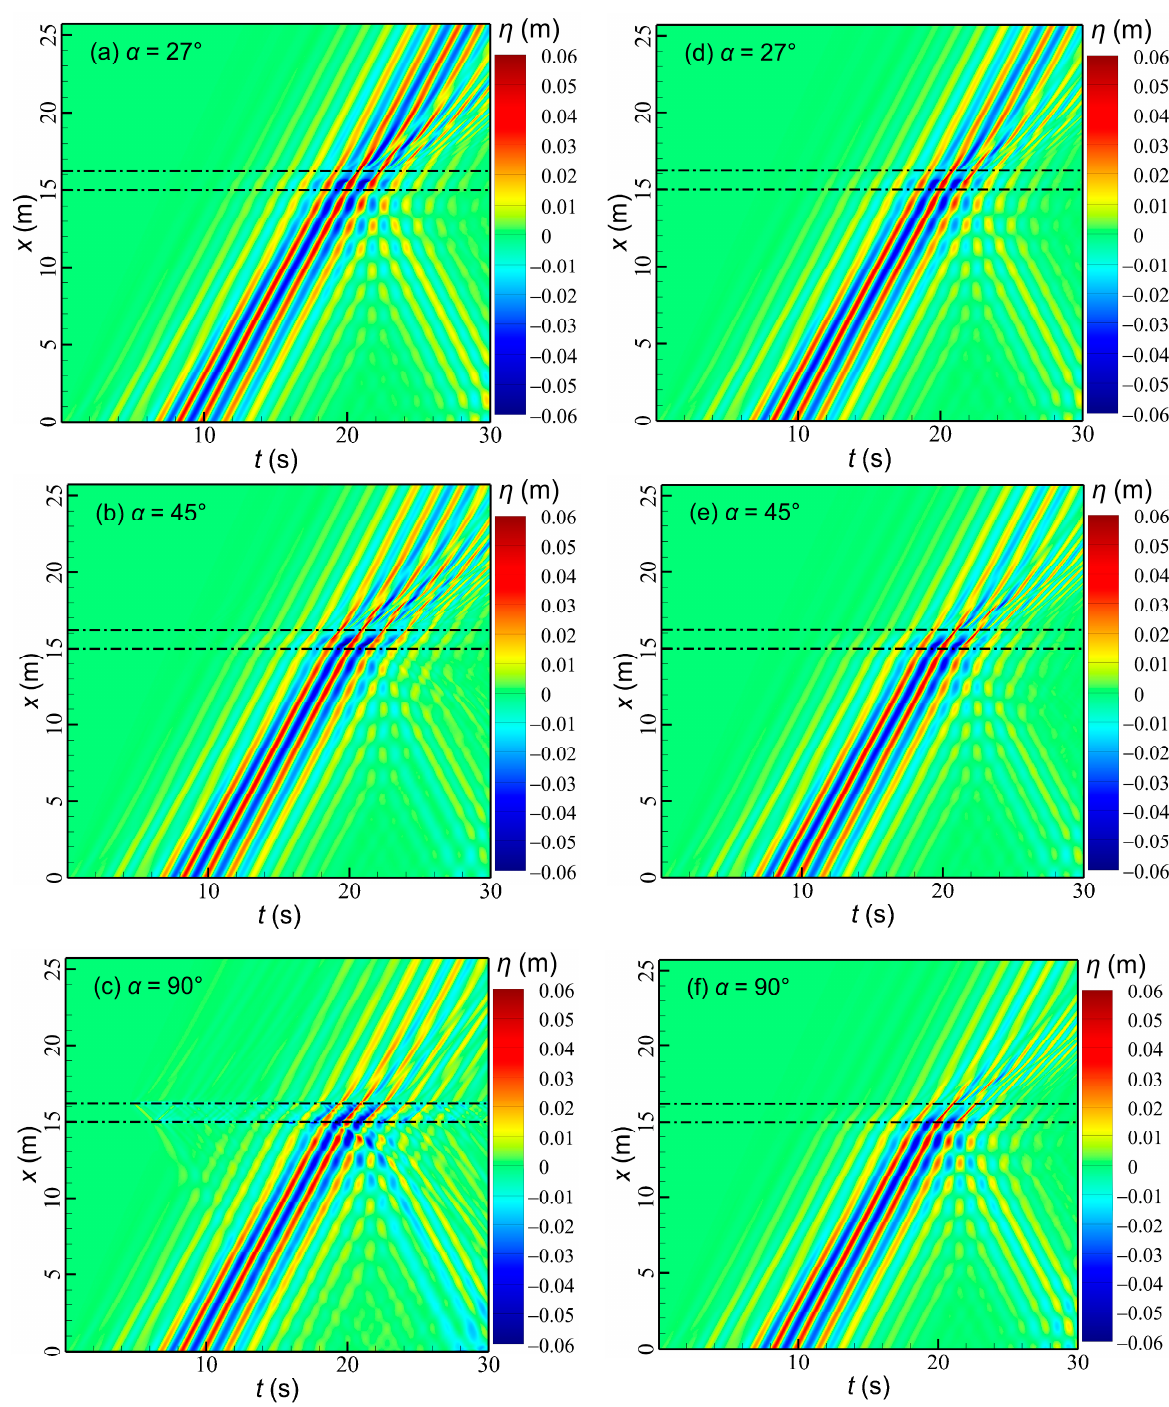
Figure 24. Space–time plots of the focused wave groups over the submerged breakwaters with different side slope angles; left side ( a – c ): submerged impermeable breakwater; right side ( d – f ): submerged permeable breakwater.